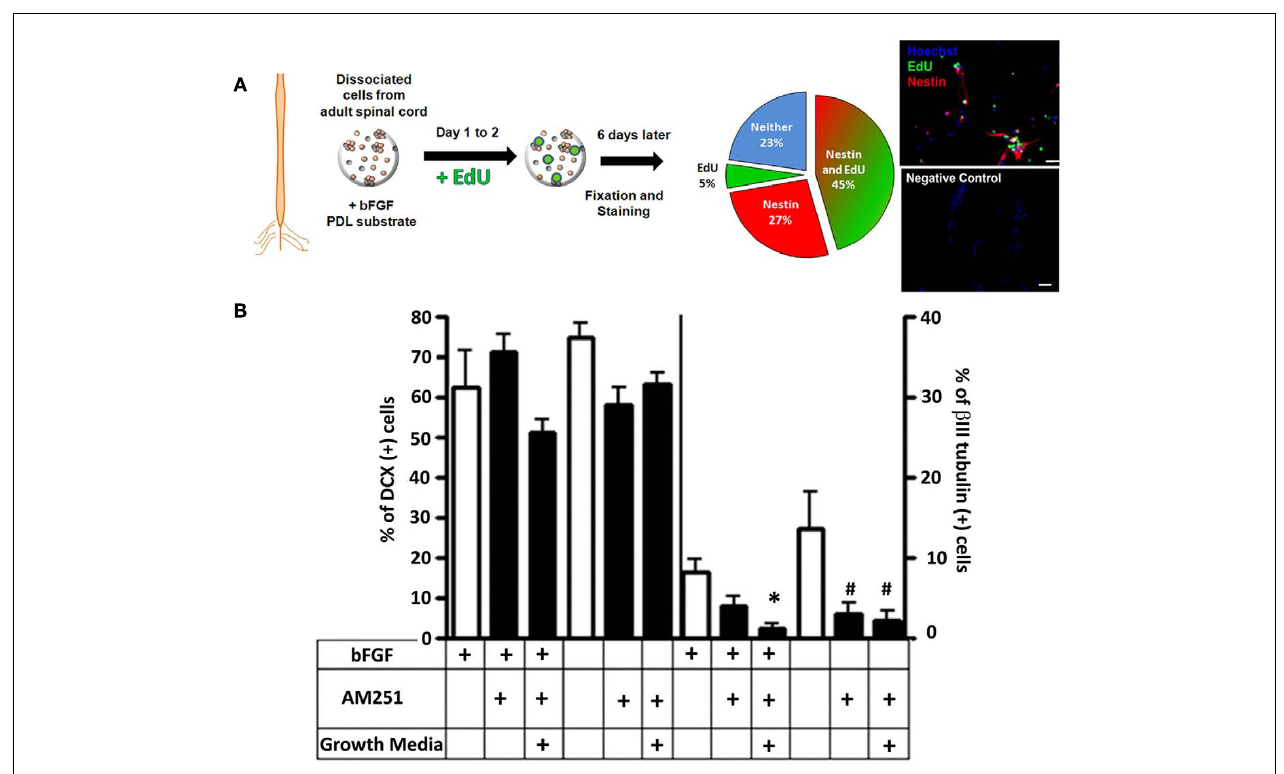
bFGF enriches for Nestin( + ) and Nestin( + )/EdU( + ) adult spinal cord progenitor cells. PDL, poly-D-lysine. Right-top panel: an image depicting cells that incorporated EdU (green), and expressed Nestin (red). Right-bottom panel: negative control, without primary antibody. Hoechst 3392 labeled nuclei (blue). 20 × Objective; Scale bars, 20 μ m. (B) Relative amounts of DCX (left panel) and β III tubulin (right panel) expressing cells under the various growth conditions.Table below graph indicates with a small “ + ” whether a certain drug or growth treatment was present. * p < 0.05; # p < 0.01With respect to their corresponding control group (one-way ANOVA, Bonferroni post